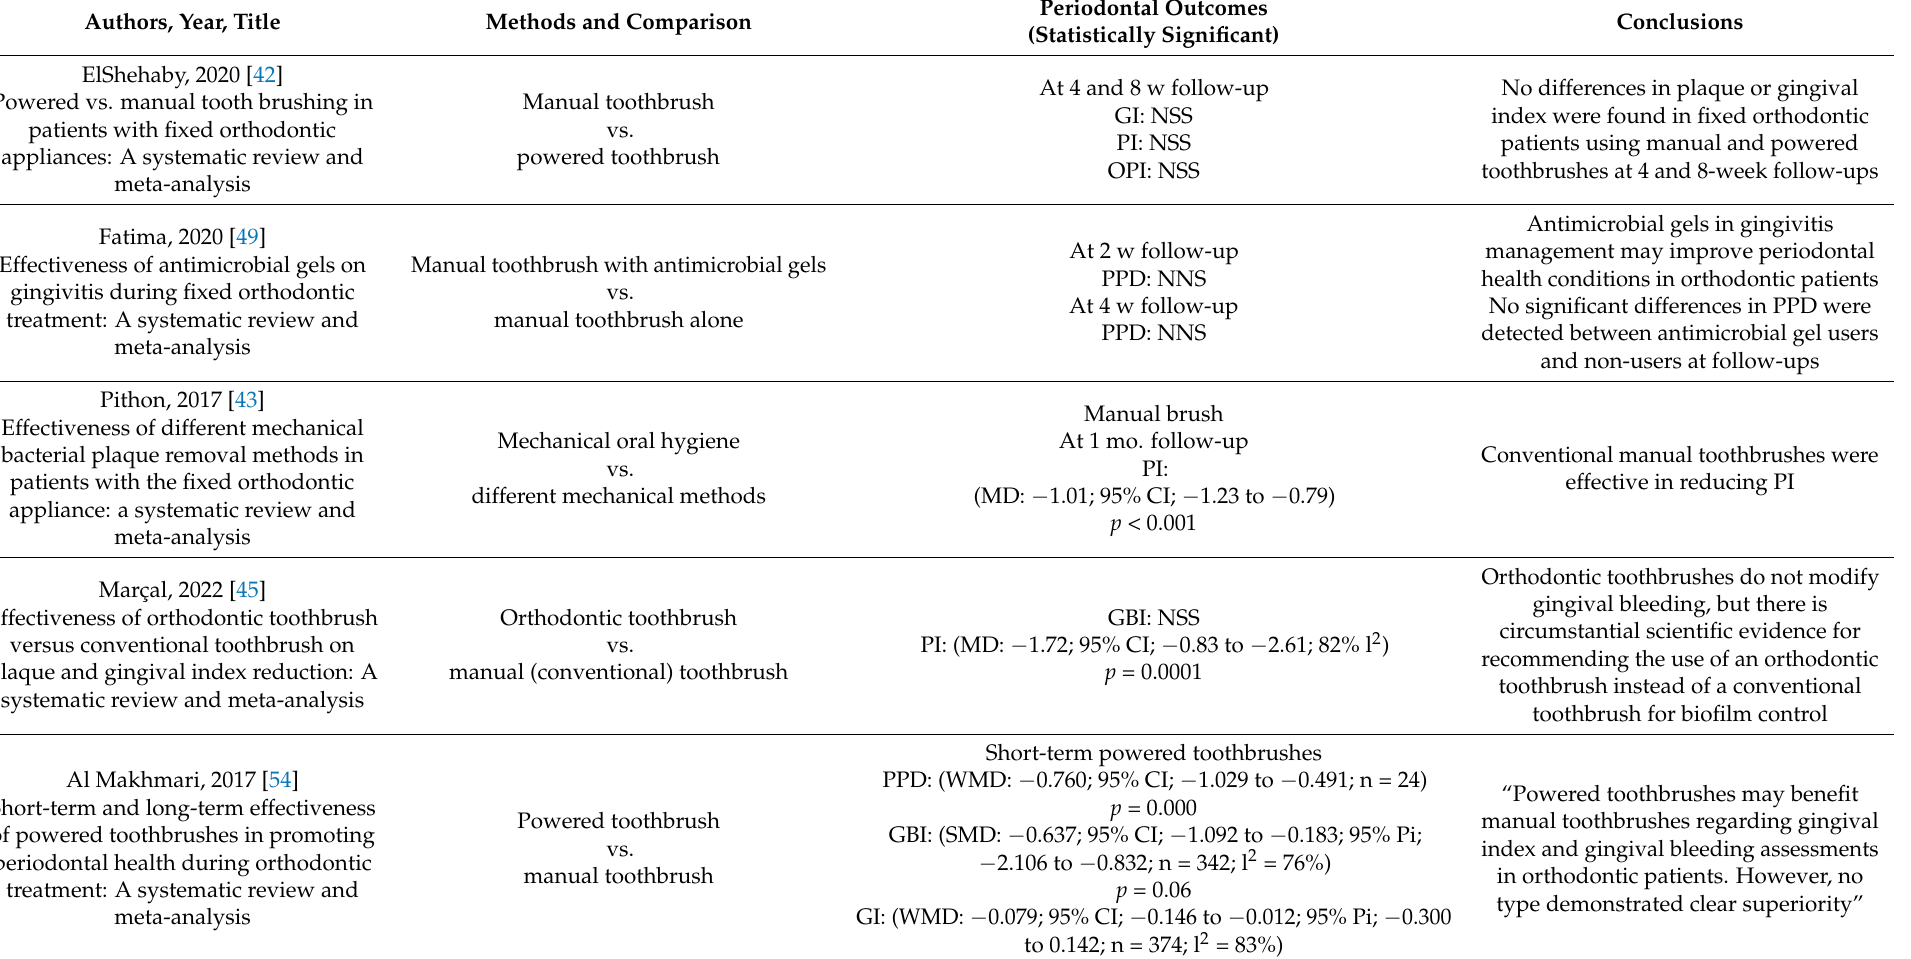
Table 2. Synthesis of periodontal outcomes reported in the currently included systematic reviews related to the self-care intervention(s) investigated in periodontally healthy patients undergoing fixed orthodontic treatment. Evidence concerning manual and powered toothbrushes are in blue, chlorhexidine-containing products in yellow, other organic products in green, probiotics in fuchsia, and motivational methods in